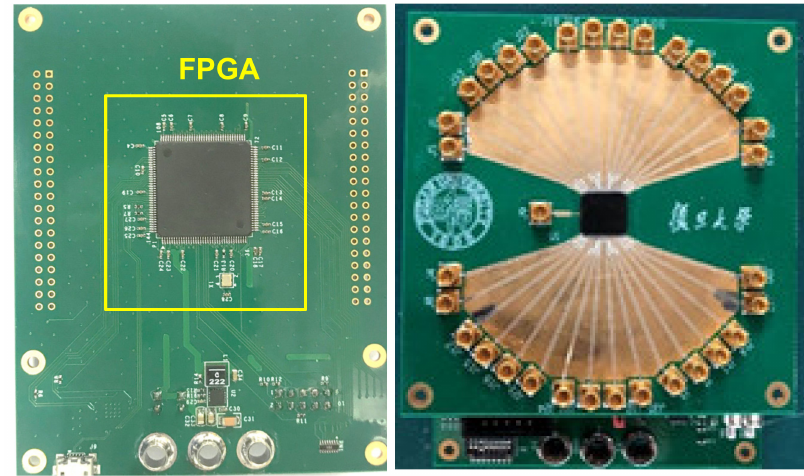
Figure 10. The timing control board and control logic for the COB.